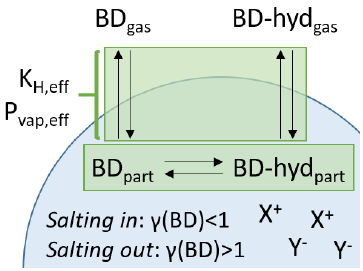
Figure 1. Schematic illustrating the meaning of effective vapor pressure, P vap , eff , and effective Henry’s law constant, K H , eff . A compound partitioning between the gas and particle phase (here, butenedial, BD) can exist in the gas phase (BD gas ). In the particle phase the compound can exist in its standard form (BD part ) but also in fast equilibrium with a “reservoir” species via reversible chemical equilibrium (here, hydrated butenedial, BD-hyd part ). The reservoir species can also partition to the gas phase (BD-hyd gas ), but with a lower vapor pressure. The formal vapor pressure and Henry’s law constant of butenedial are related to the equilibrium between BD gas and BD part alone. In contrast, P vap , eff and K H , eff are related to the equilibrium between the gas phase and the combined particle-phase abundance of both BD and reservoir species BD-hyd. Additionally, P vap , eff and K H , eff can be modulated by the presence of inorganic ions in the particle phase, shown here as generic cations X + and generic anions Y − , which may have a salting-in or salting-out ef-